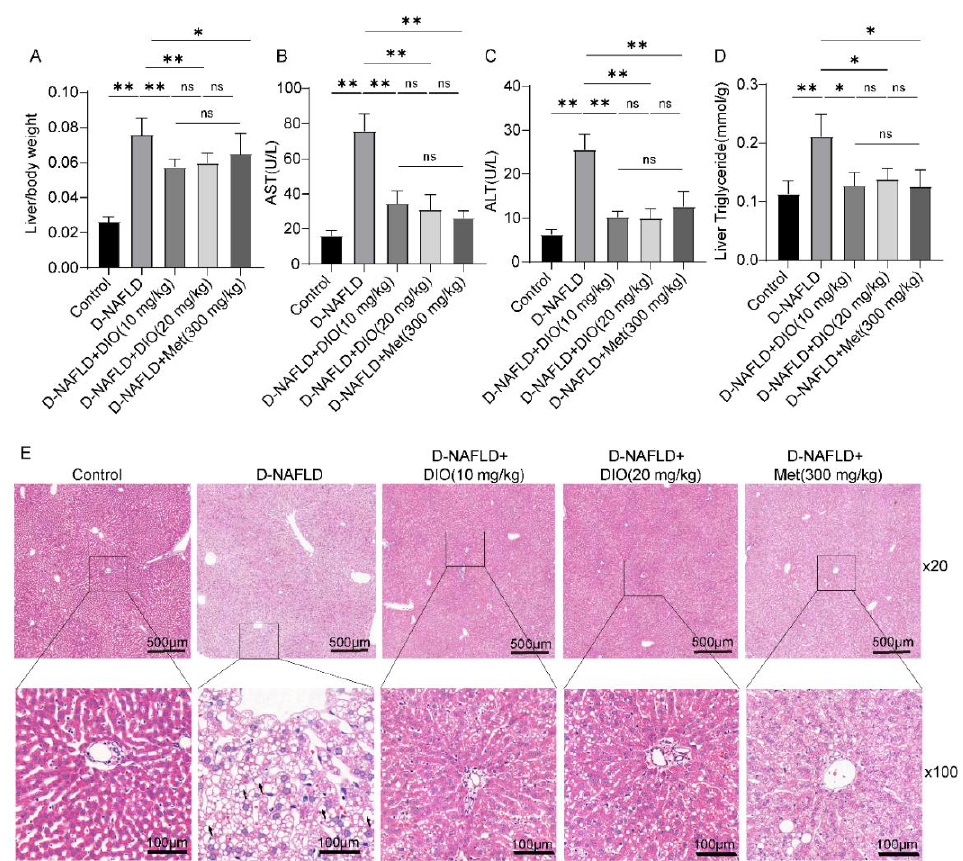
Figure 3. DIO ameliorated liver damage and lipid deposition in D-NAFLD rats. ( A ) Liver/body weight. ( B ) Serum AST(U/L). ( C ) Serum ALT(U/L). ( D ) Liver triglyceride(mmol/g). ( E ) H&E staining of the liver (×20 and ×100) (black arrow, lipid vacuolation). Data in ( A – D ) ( n = 8) and data in ( E ) ( n = 3) were presented as mean ± SD. * and ** indicate significant difference and highly significant difference, respectively.